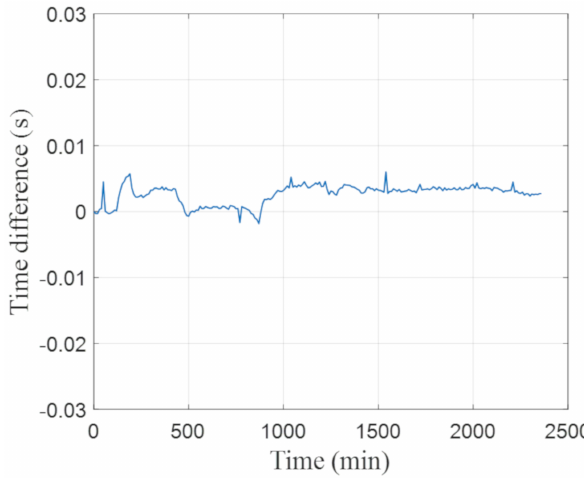
Figure 7. Time drift with Google NTP